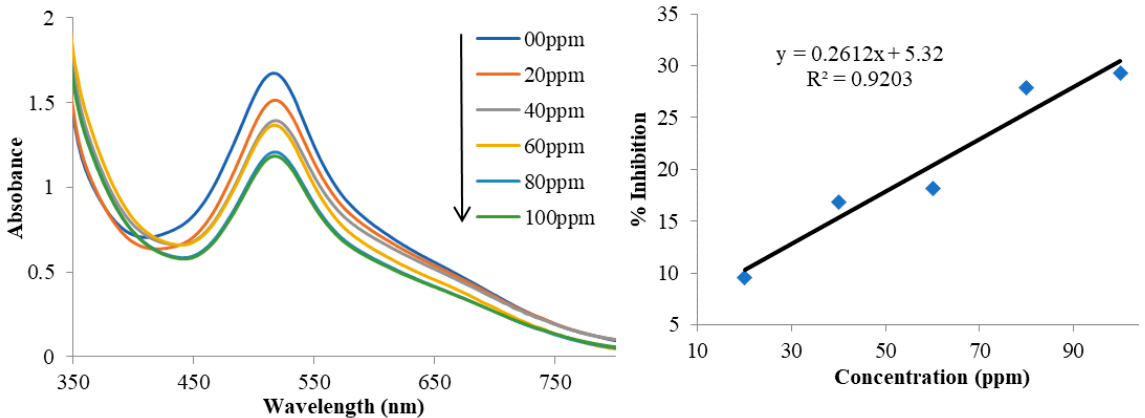
Figure 13. Absorption spectra of compound 1 . Arrow shows the decreasing change in absorption spectra of the compound/DPPH mixture on increasing concentration of the compound ( left ). Graph- ical representation of % Inhibition versus concentration of compound 1 for radical scavenging ac- tivity ( right ).